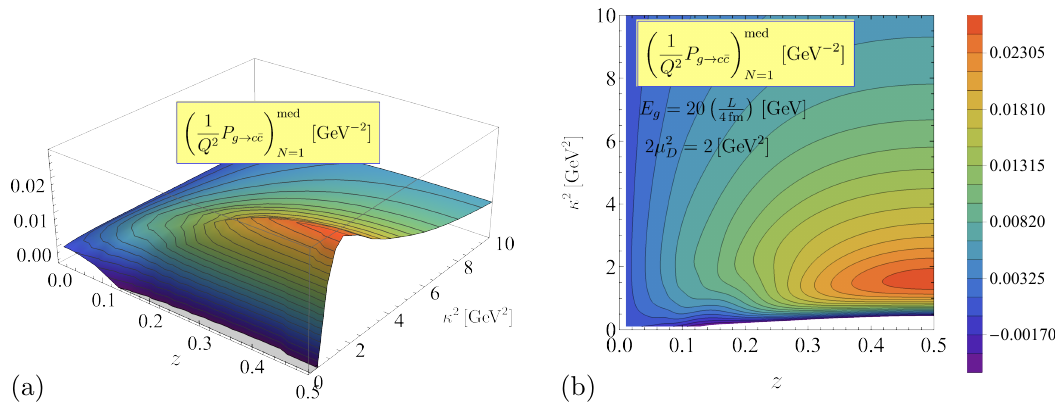
Figure 3 . The medium-modification of the g → c ¯ c splitting evaluated in the N = 1 opacity approx- imation for ‘hard’ Yukawa-type scattering centres (3.20). Each panel shows different viewpoints on the results for typical momentum squared 2 µ 2 = 2 GeV 2 transferred from the scattering D